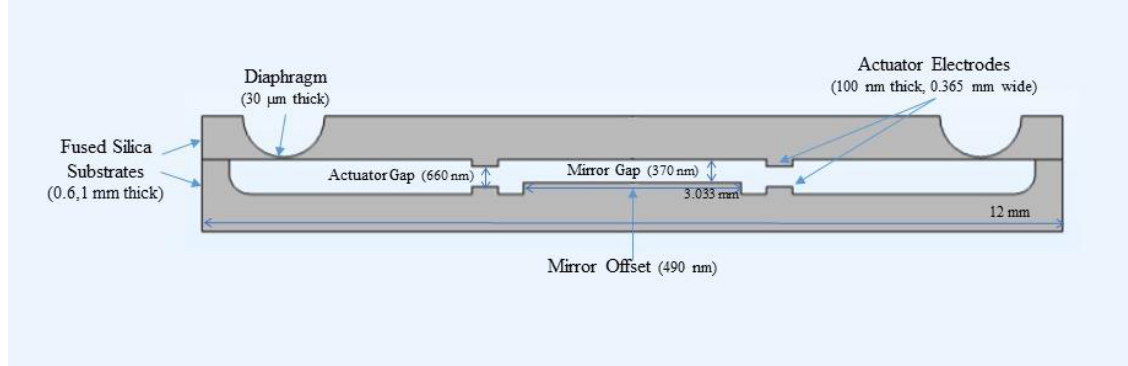
Figure 3. Cross sectional view of the MEMS actuated filter, with the dimensions indicated. As indicated by the dimensions in Figure 3, the filter is designed to be in the millimeter scale, and it should be operated at appropriate voltages. The upper substrate has a thickness of 0.6 mm and a diameter of 12 mm, while the lower substrate has the same diameter but a thickness of 1 mm. The mirror diameter is determined to be 3.033 mm and